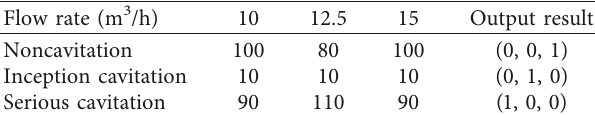
Figure 10: Space distribution of principal components based on PCA. Table 4: Input samples and arranged outputs.